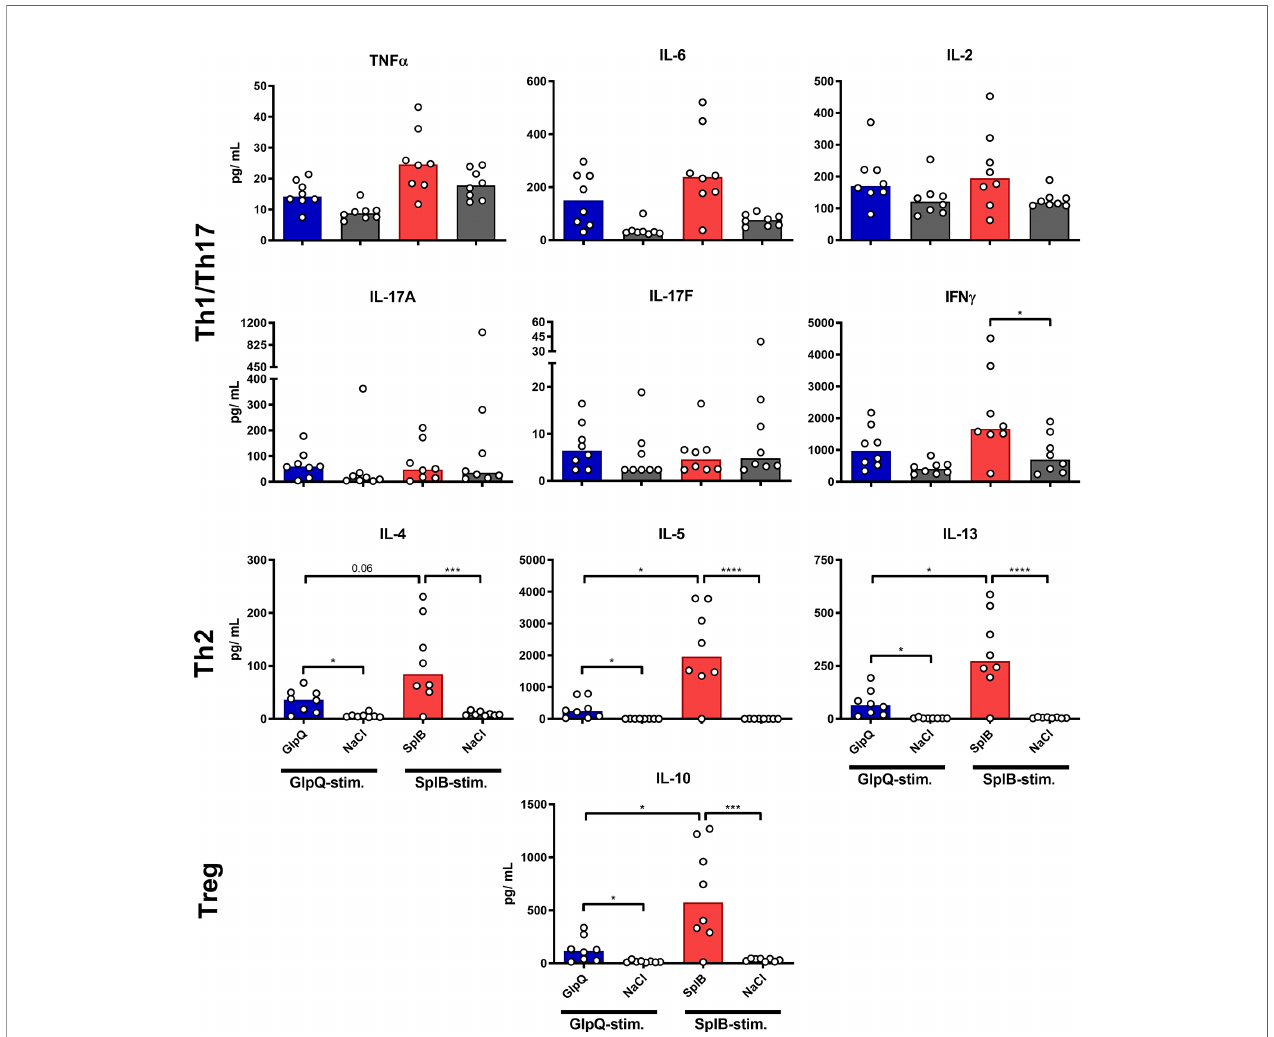
FIGURE 2 | SplB but not GlpQ promoted Th2 cytokine production. Isolated splenocytes were restimulated with the indicated vaccine antigen for 4 days, afterward the supernatant was harvested and the concentration of produced cytokines was measured via the LEGENDplex ™ Mouse Th Cytokine Panel (13-plex). Data are presented as median. n = 8 animals per group. *p < 0.05; ***p < 0.001; ****p < 0.0001. Group comparisons that are de fi ned in the “ Statistical analysis ” section but not shown here are not signi fi